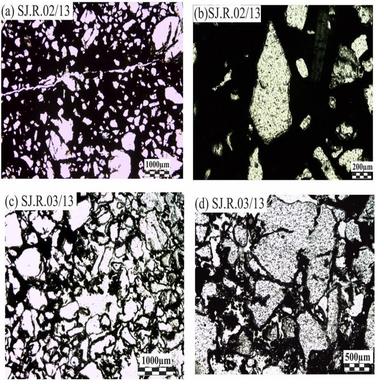
Photomicrographs of FSS samples SJ.R.02/13 (N. Srª da Conceição bulwark) and SJ.R.03/13 (west wall covered road): (a) General texture of sample SJ.R.02/13, in which quartz grains are cemented by oxyhydroxides of Fe; (b) Detail of the angular grains in the SJ.R.02/13 sample; (c) General texture of the SJ.R.03/13 sample, where poorly selected quartz grains occur predominantly in ferruginized cement; (d) Detail of the SJ.R.03/13 sample, in which observed grains of quartz are quite fractured and have corrosion